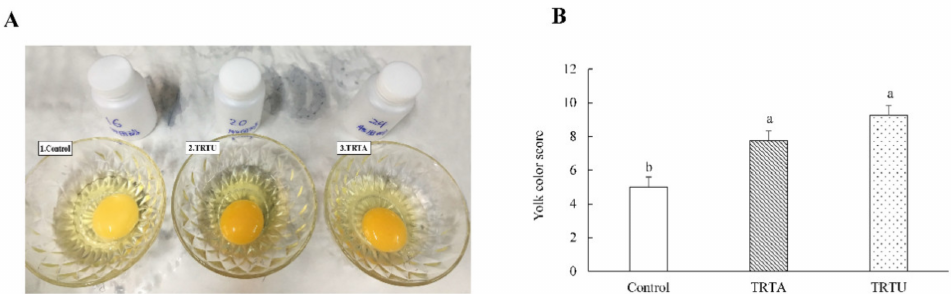
Figure 1. Egg yolk color ( A ) and statistical analysis of egg yolk color ( B ) of laying hens (36 weeks of age) fed diets containing alfalfa (TRTA) or U. cannabina (TRTU). Data points are group means ± SEM. a,b Denotes significant ( p < 0.05) di ff erences among the